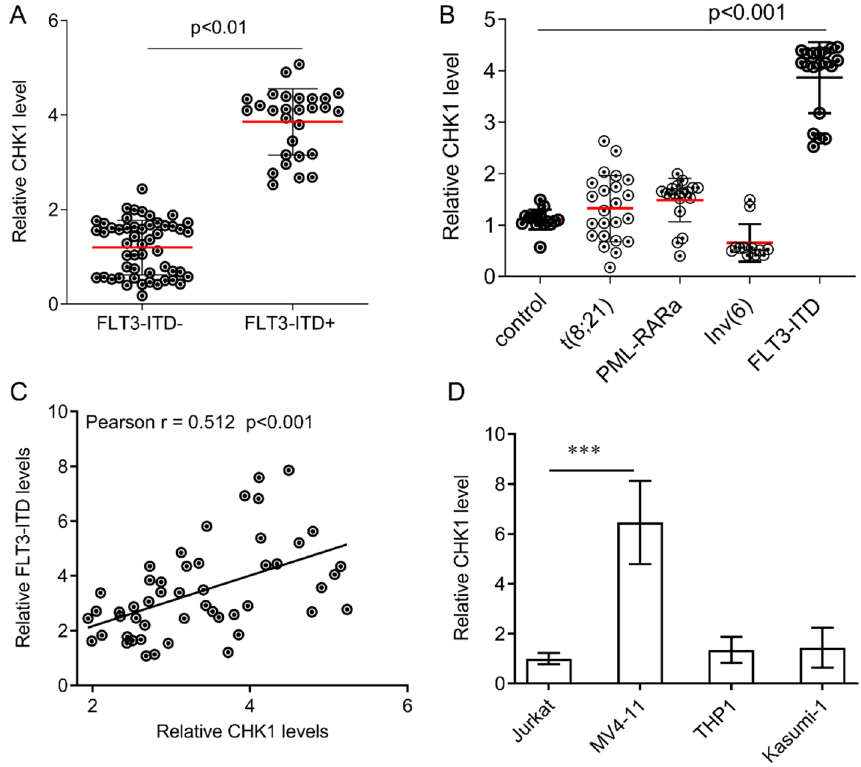
Figure 2. The expression of CHK1 is positively correlated with the expression of FLT3-ITD. ( A ) qRT-PCR was used to detect the expression of CHK1 in CD34 + CD38 − cells in bone marrow samples of FLT3-ITD positive and negative AML patients. ( B ) qRT-PCR was used to detect the expression of CHK1 in CD34 + CD38 − cells from bone marrow samples of t (8; 21), PML-RARa, Inv (16) and FLT3-ITD positive AML patients. ( C ) Correlation of between CHK1 and FLT3-ITD (Pearson test, R = 0.512, p < 0.001). ( D ) Detection of CHK1 expression in AML cell line by qRT-PCR. Data are expressed as mean ± SEM. *p <